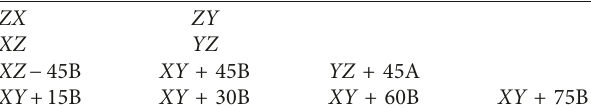
Table 3: Codes for test specimen orientation corresponding to Figure 4, with similar choice of colours. Orientation annotation is according to ISO/ASTM